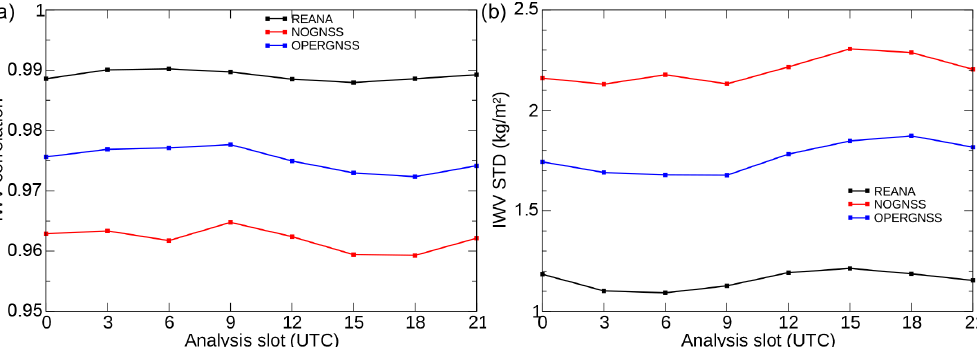
Figure 2. Correlation (a) and standard deviations ( b , in kgm − 2 ) of integrated water vapour (IWV) content from reprocessed GNSS obser- vations (Bock et al., 2016) and AROME-WMED analyses (REANA in black, NOGNSS in red and OPERGNSS in blue) as a function of the analysis slot